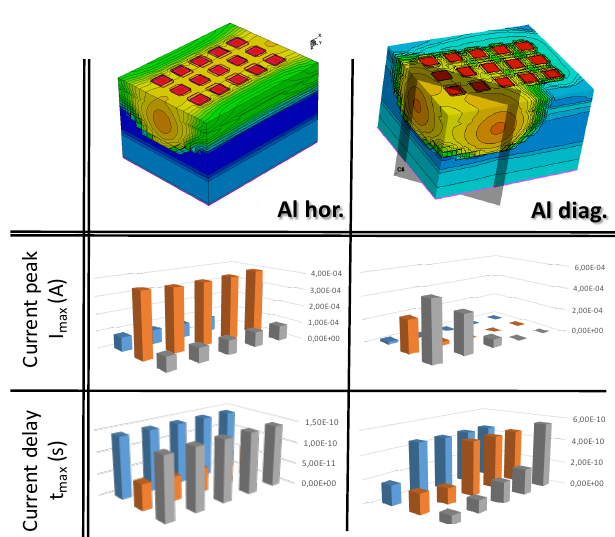
Fig. 7. Variation of the current peak and current delay at the output of the 15 pixels for the aluminum generated horizontally and diagonally.